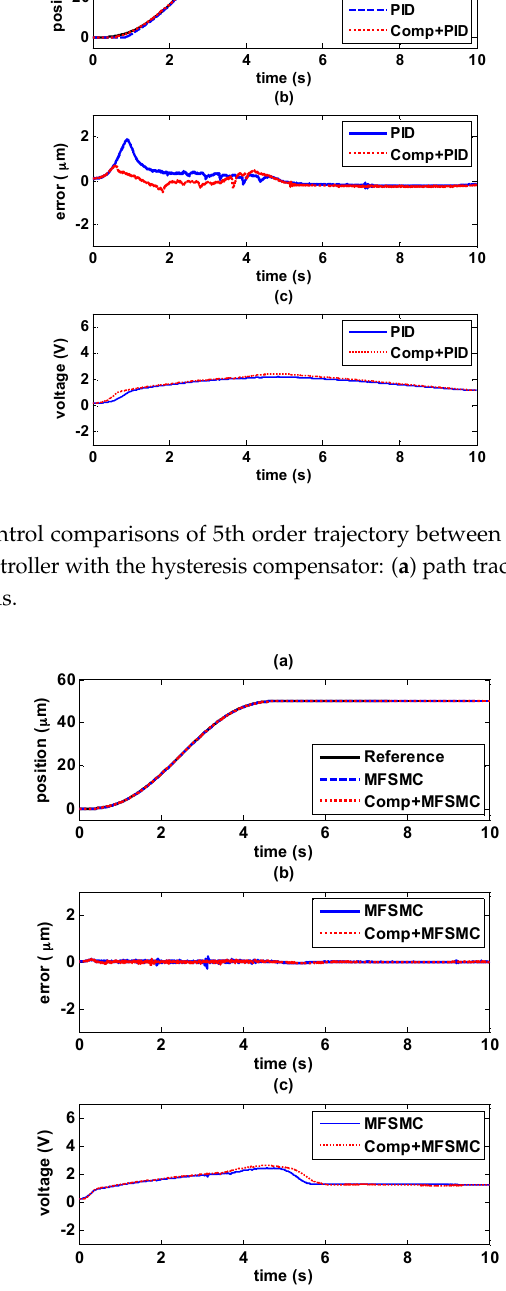
Figure 22. Tracking control comparisons of 5th order trajectory between using MFSMC path controller solely and MFSMC path controller with the hysteresis compensator: ( a ) path tracking responses; ( b ) control errors; ( c ) control signals.